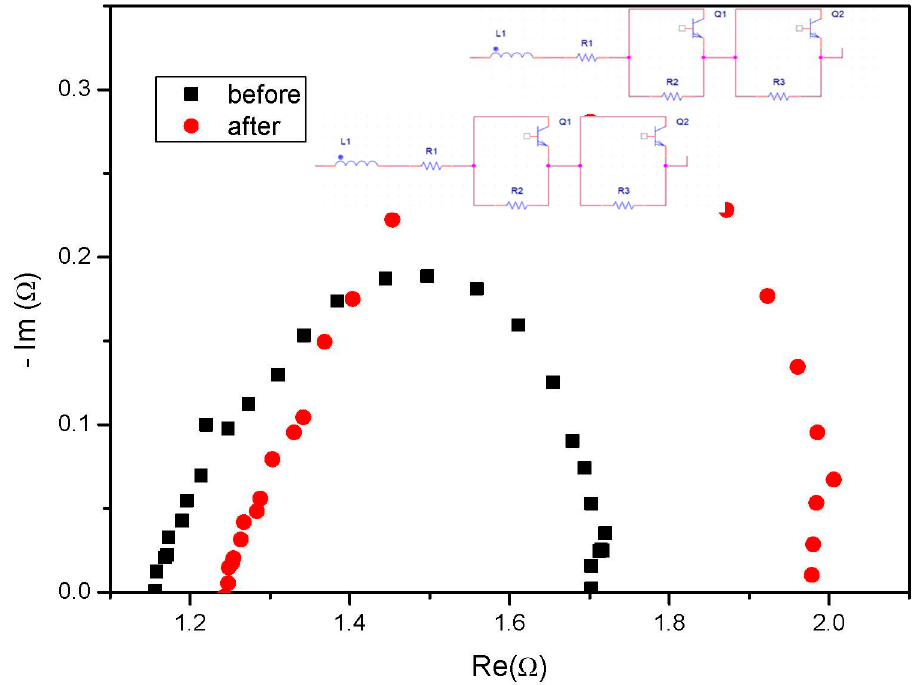
Figure 5. Stability determination from the Nyquist plots of the EIS measurements (from 100 kHz to 1 MHz) before and after 100